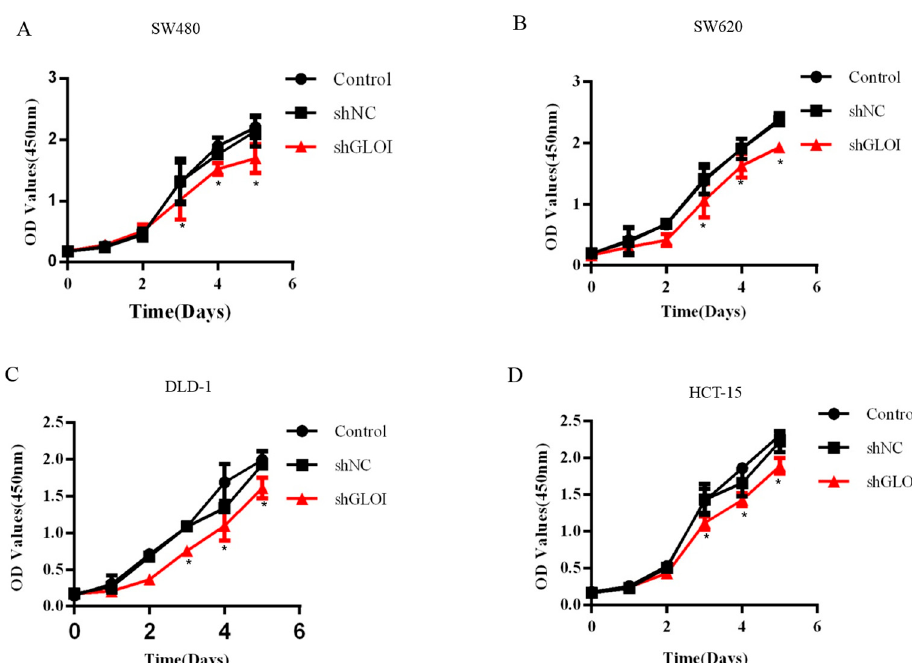
Figure 3. GLOI knockdown inhibits colorectal cancer (CRC) cell viability. ( A – D ) SW480, SW620, DLD-1, and HCT-15 CRC cells were transfected with shGLOI or shNC. The growth of the cells was monitored for 5 days. Optical density (OD) * p < 0.05. All data are representative of three independent experiments ( n = 3).